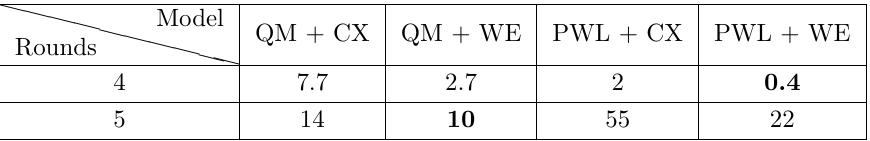
Table 4: Solving times for AES over 4 and 5 rounds depending on the modeling. Timings are given in seconds, for the full solve for 4 rounds and over a subset of all cases for 5